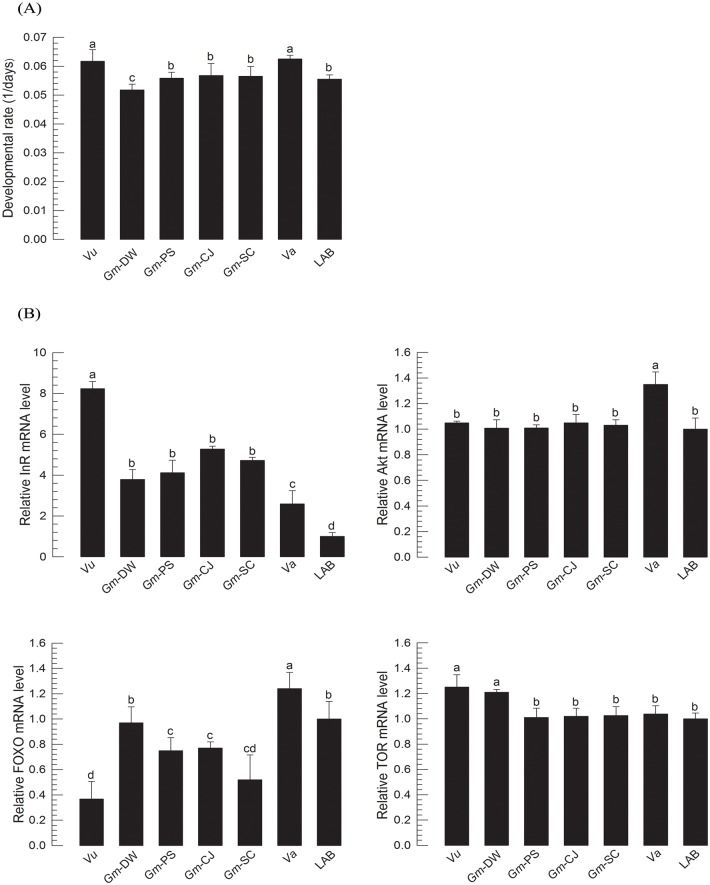
Validation of IIS-growth regression model between IIS expression levels and larval developmental rate of M. vitrata.Practical growth patterns of M. vitrata larvae were obtained by rearing larvae in the laboratory with artificial diet (‘LAB’) and six natural hosts: Vigna unguiculata Jangchae (‘Vu’), Glycine max Daewon (‘Gm-DW’), Glycine max Pungsannamul (‘Gm-PS’), Glycine max Cheongja-3ho (‘Gm-CJ’), Glycine max Socheongja (‘Gm-SC’), and Vigna angularis Hongeon (‘Va’). (A) Effect of host on larval growth. Developmental rate was calculated by inverse of the total larval period (days). Each host treatment used 30 larvae. (B) Change in expression levels of four IIS component genes (InR, Akt, FOXO, and TOR). These four genes’ expression levels in L5D1 of larvae reared on different hosts from L1 were quantified. Each treatment used nine randomly selected larvae. mRNA levels were relatively quantified and compared to mRNA levels in laboratory strain L5D1 reared with artificial diet. Actin was used as reference gene in RT-qPCR to normalize target gene’s expression level. Different letters above standard deviation bars indicate significant difference among means at Type I error = 0.05 (LSD test). (C) T-tests between the expected larval period (L1D1-L5D5) from regressions obtained from IIS gene expression levels and the observed larval period (L1D1-L5D5). Asterisk indicates significant difference between expected and observed values. ‘NS’ represents no significance at Type I error = 0.05.